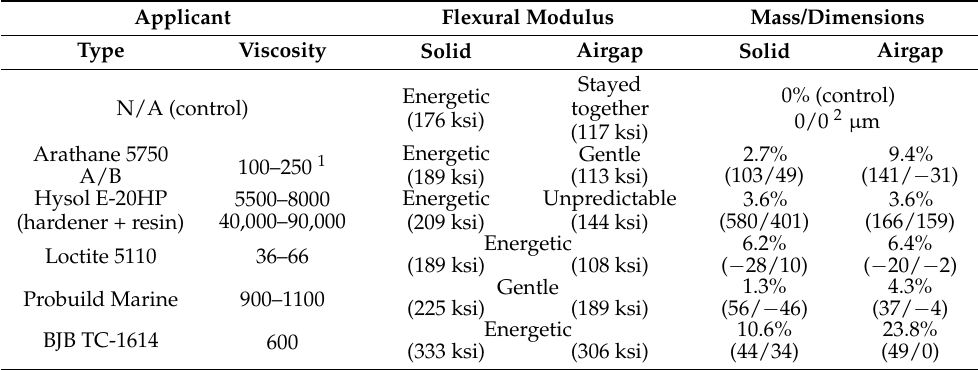
Table 2. Break characteristics, flexural modulus, and dimensions/mass change in samples according to applicant types and airgap configuration [51–55]. Figure 7. The threaded insert ( left , avionics box) and radial cracks around it ( right , specimen) [51]. Credit: NASA.